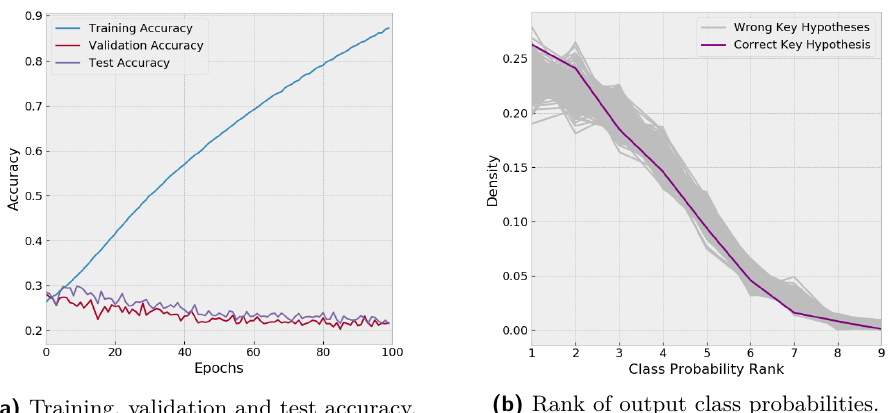
Figure 3: Machine learning metrics and class probability ranks for the ASCAD database (1 000 traces) and